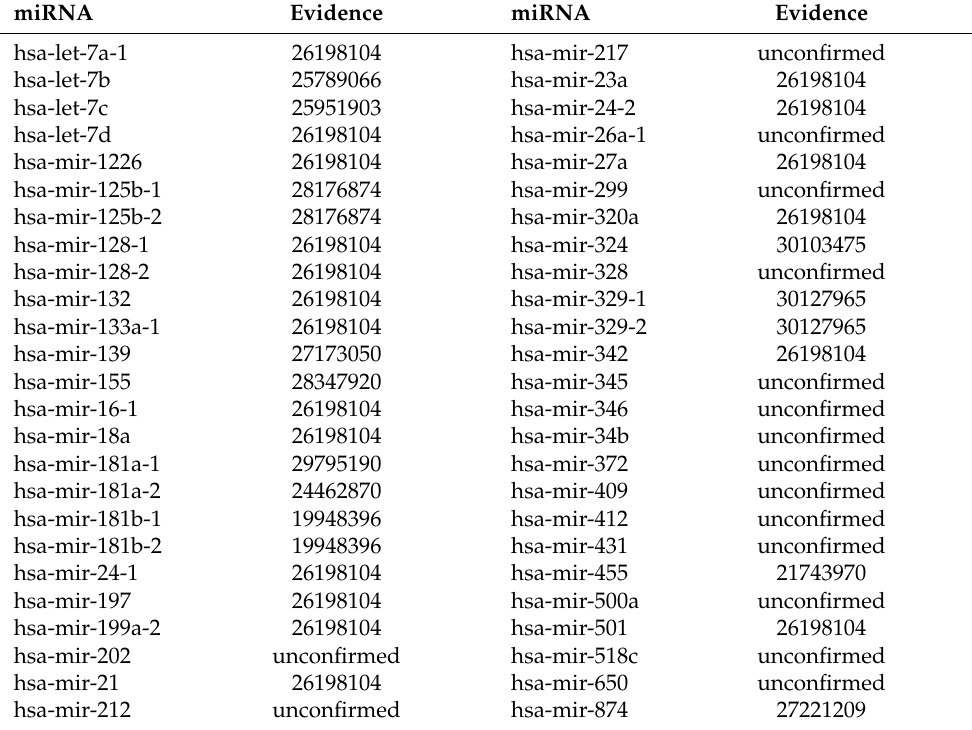
Table 7. The top 50 SM–miRNA associations predicted by AMCSMMA in the second type of case study to the SM